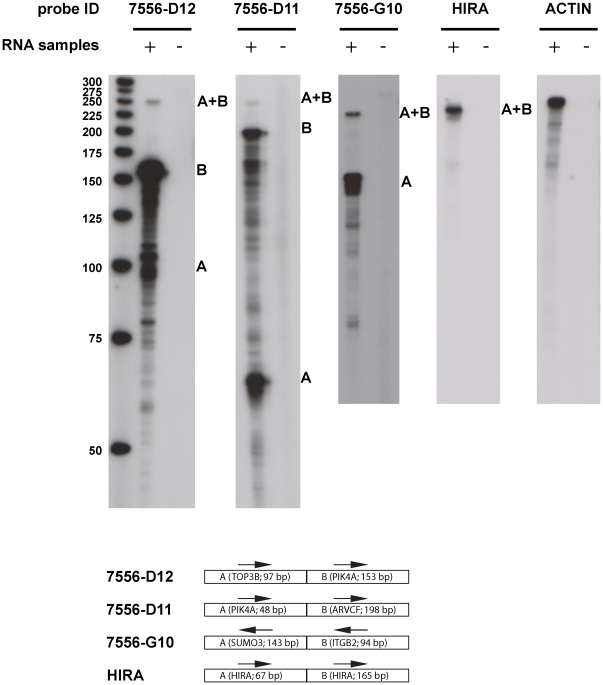
RNAse protection assays to validate predicted fusion/chimeric transcripts.Each panel on top shows the autoradiographs of the probe that covers the predicted chimeric RNA fragment against human RNA from tissue pools detailed in table S2. In each panel, “+” and “−” indicate the tracks with presence and absence of input RNA, respectively. The RNA size ladder is shown on the left of the figure (unit: nucleotides). The bottom of the figure schematically shows the two components of each predicted chimeric transcript. For example, clone 7556-D12 contains 97 bases of an exon of gene TOP3D (designated A) joined to a 153-base exonic fragment of gene PIK4A (designated B); both fragments are in the same genome strand orientation (shown by arrows). In the top first panel corresponding to clone 7556-D12, the protected chimeric fragment in the RNA“+” lane is labeled A+B. The protected (non-chimeric) exons B and A are also shown. The other 2 validated chimeric fragments are shown in the second and third top panels. The fourth panel contains a control exon-exon junction of gene HIRA. The fifth panel contains a control actin gene fragment. A total of 3 out of 15 predicted and tested chimeric fragments were validated using this method. For more details on these experiments see Material and Methods, and for the genomic coordinates of the fragments see table S2.